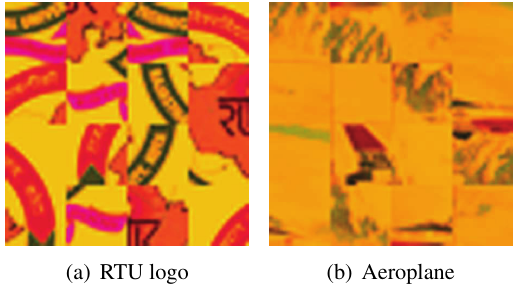
Figure 6: RGB watermark images.